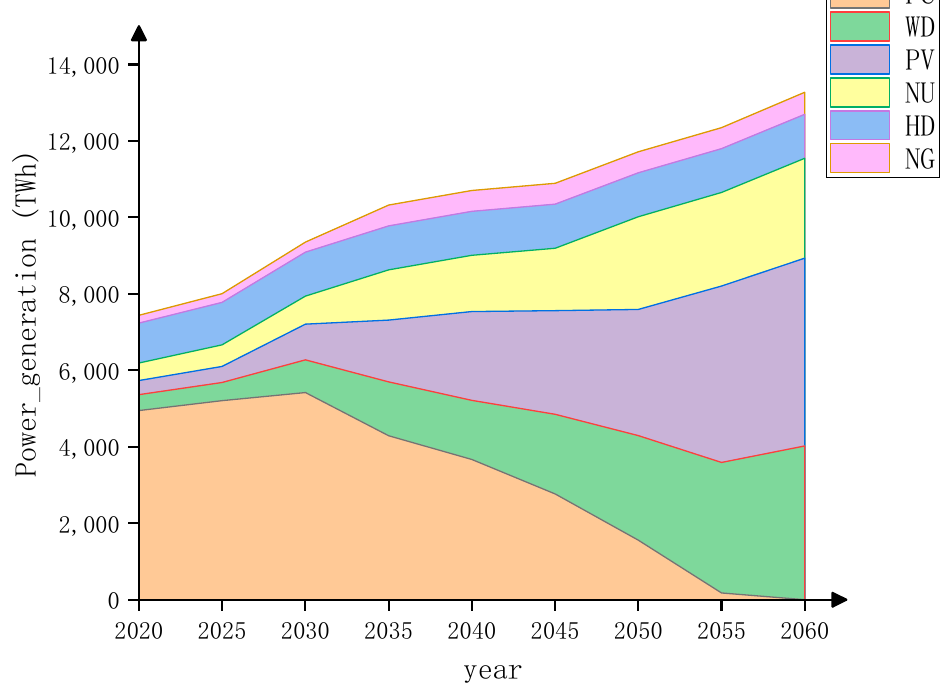
Figure 2. National power structure in the BAU scenario between 2020 and 2060. (NG—gas power generation, HD—hydroelectric, NU—nuclear power, PV—photovoltaic power, WD—wind power, PC—coal power).